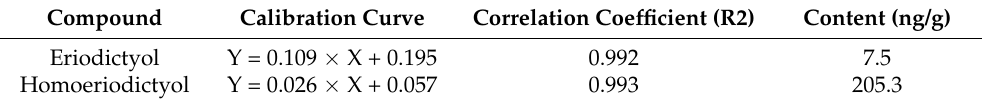
Figure 1. Content of Eri and Hom in the brain detected by UPLC-MS/MS. ( A ) The chromatogram of eriodictyol. ( B ) The chromatogram of homoeriodictyol. ( C ) Brain tissue samples of eriodictyol. ( D ) Brain tissue samples of homoeriodictyol. Table 1. Linear regression equations and detection limits for eriodictyol and